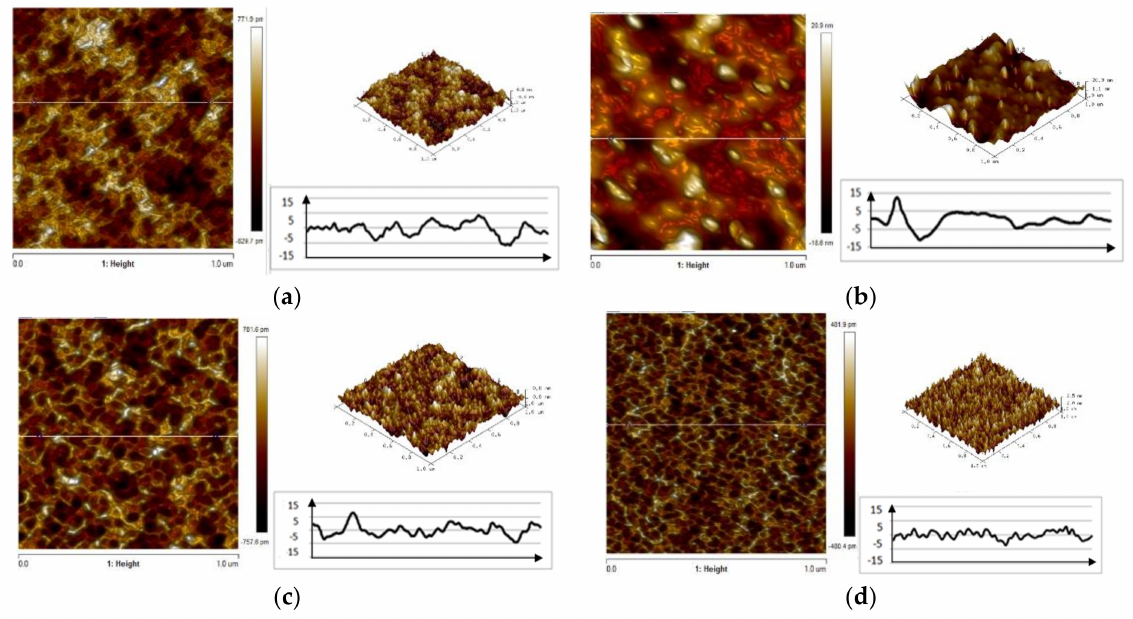
Figure 4. AFM images of the surface of coatings deposited od steel X20Cr13: VTMS/EtOH/AcOH ( a ), VTMS/EtOH/ LiClO 4 ( b ), VTMS/EtOH/H 2 SO 4 ( c ), VTMS/EtOH/NH 3 ( d ). Pictures were taken using an AFM NanoScope V MultiMode 8